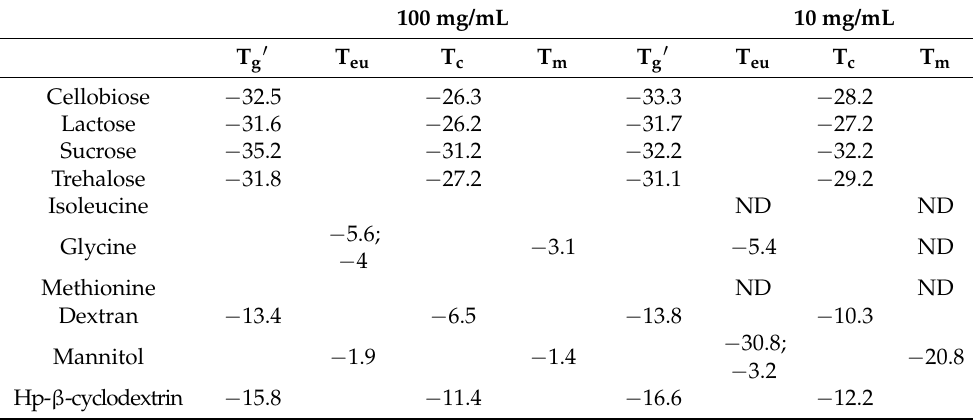
Table 2. Results of DSC and FDM measurements. ND represents not detectable